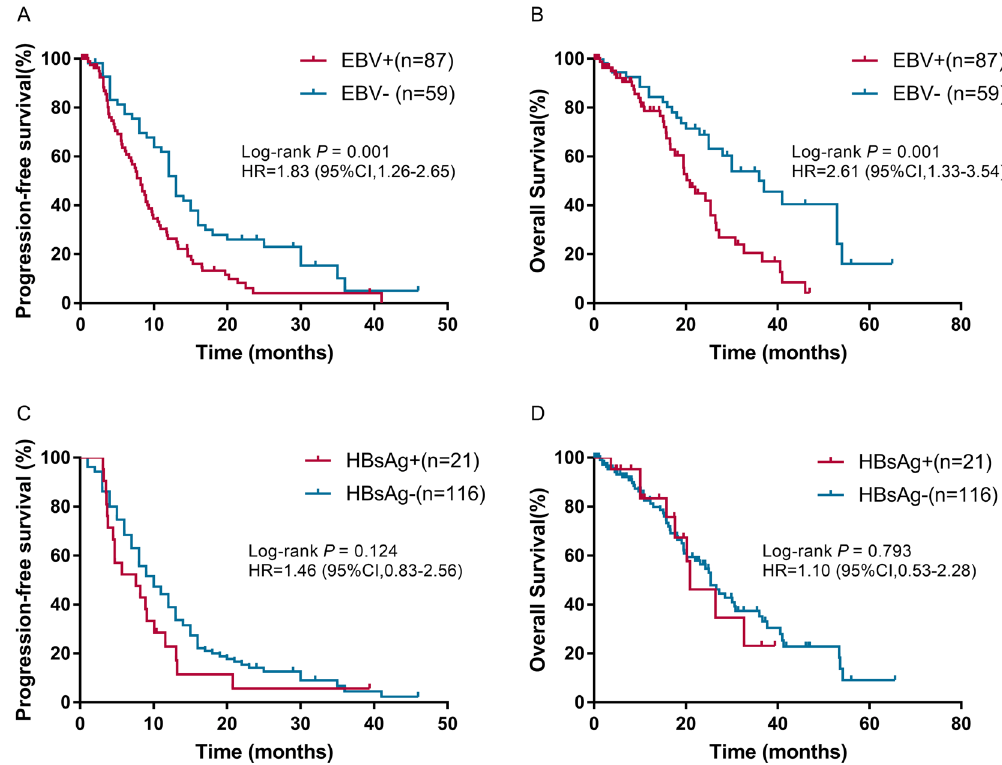
Figure 3. Kaplan–Meier estimate of PFS and OS according to the EBV ( A , B ) and HBsAg status ( C , D ). PFS, progression-free survival; OS, overall